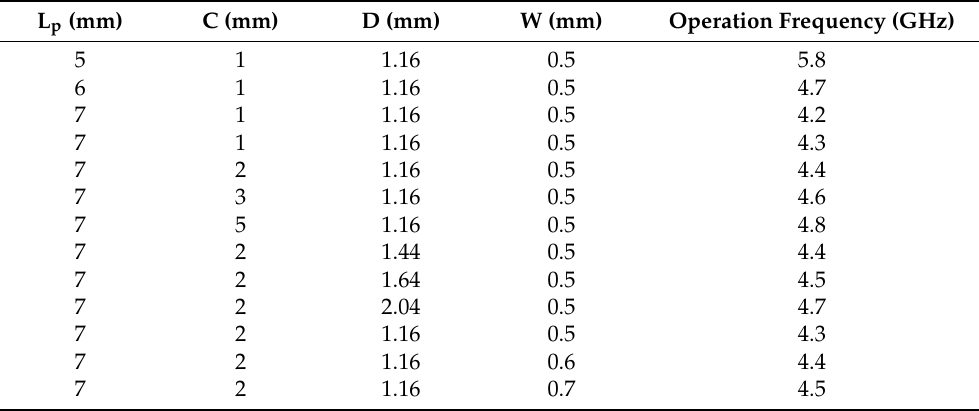
Table 2. Effects of geometric parameters on operation frequency.